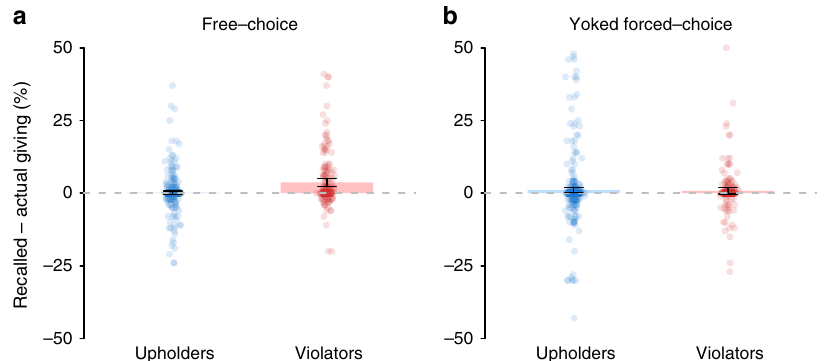
Fig. 4 Choice-independence of self-serving memory errors. a In Experiment 4a, free-choice violators exhibited self-serving memory errors. b In contrast, in Experiment 4b, participants forced to make identical choices as violators exhibited no such bias toward self-serving memory errors. Error bars represent